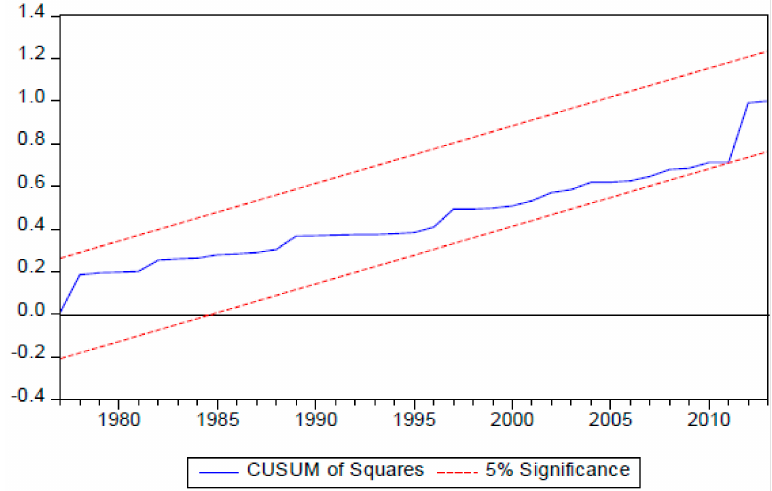
Figure 12. Plot of cumulative sum of squares recursive residuals for